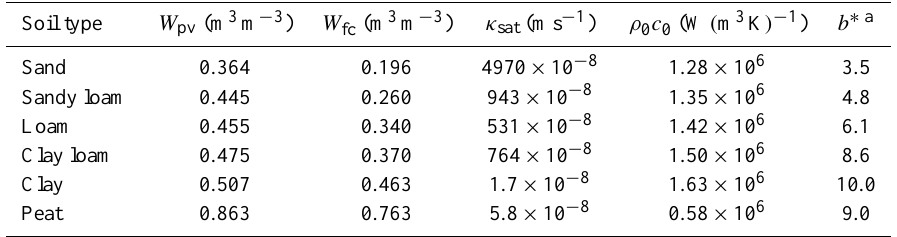
Table B1. Soil parameters from Doms et al. (2011).